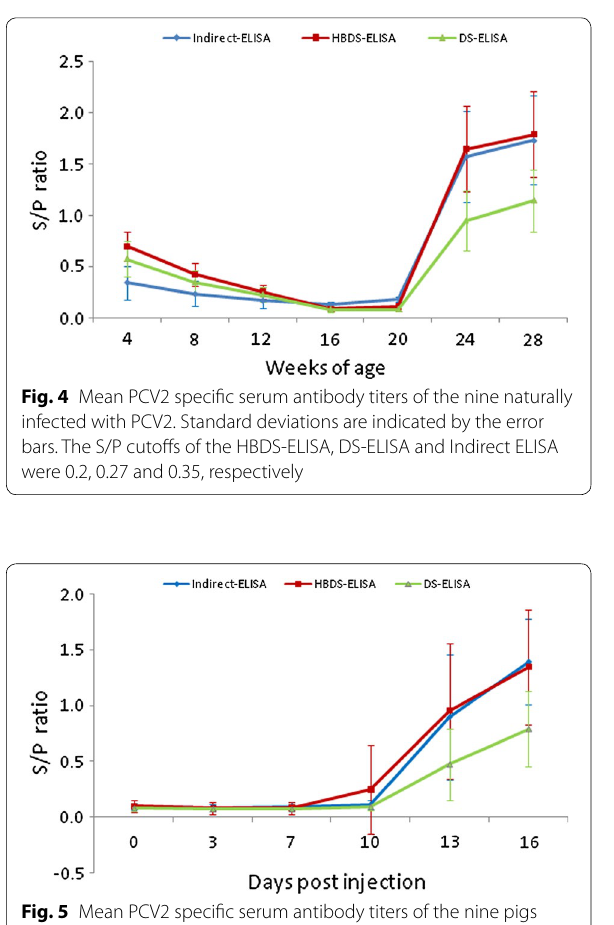
a S/P ratio cutoffs: positive b